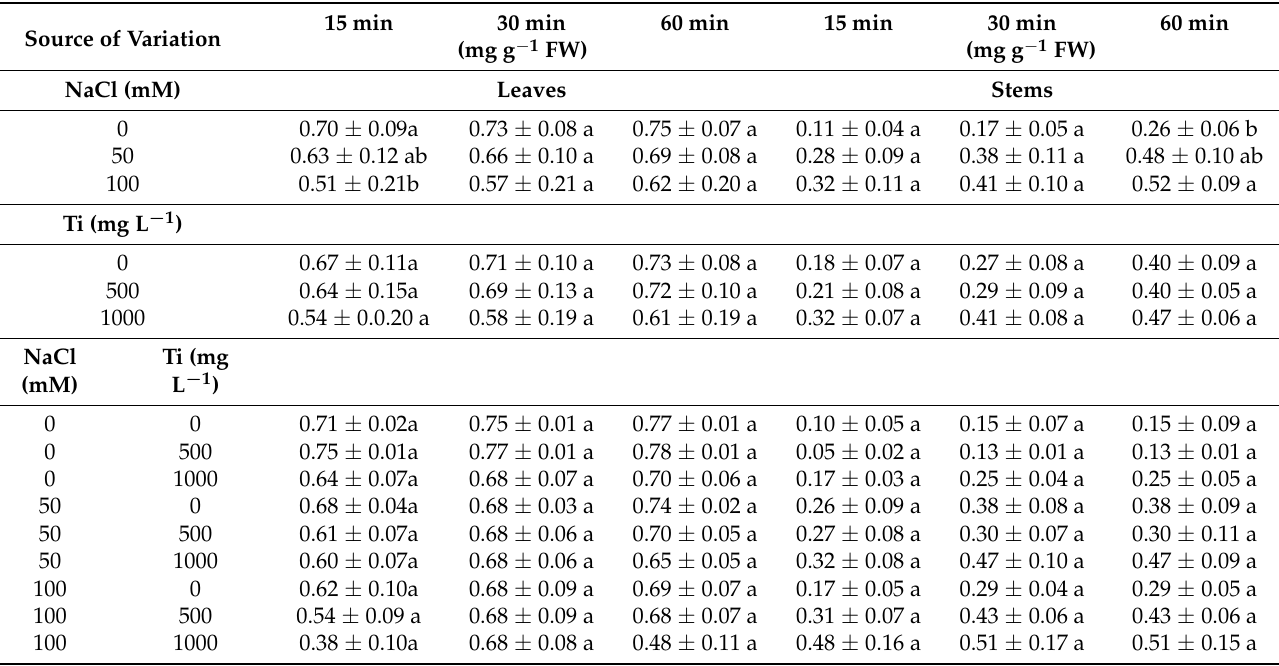
Table 5. Main and interaction effects of NaCl and TiO 2 on antioxidant activity at 15, 30, and 60 min in leaves and stems of tomato ( Solanum lycopersicum L.) seedlings cv. Rio Grande.